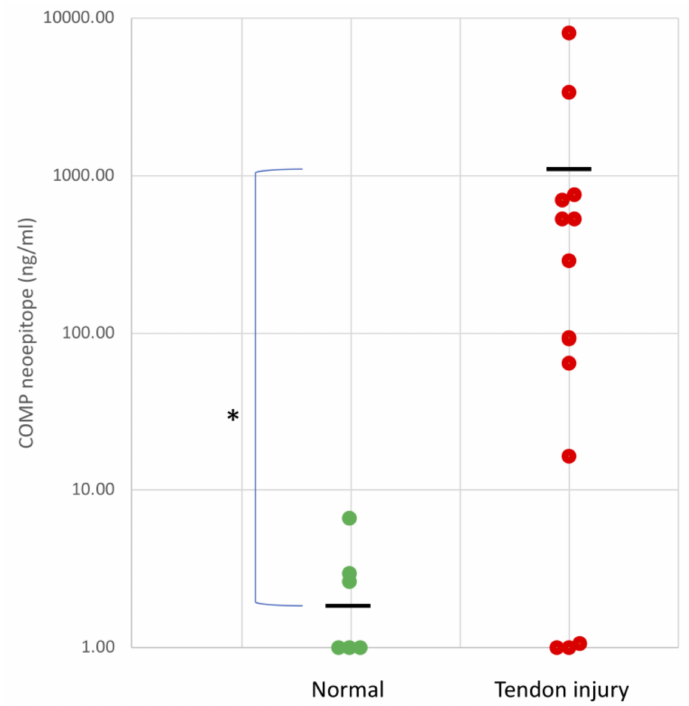
Figure 6. Quantification of the neoepitope in synovial fluids from normal tendon sheaths ( n = 6) and from tendon sheaths containing tendon injury ( n = 14). Samples with values under the detectable range of the assay were given a value of 1 ng / mL which is the limit of detection of the assay. Lines show the mean levels for each group. Note the logarithmic scale on the y axis to enable comparison between normal and cases and the large di ff erence in neoepitope concentration between normal ( < 10 ng / mL) and those with injury (an average of 500-fold higher; * p = 0.013).